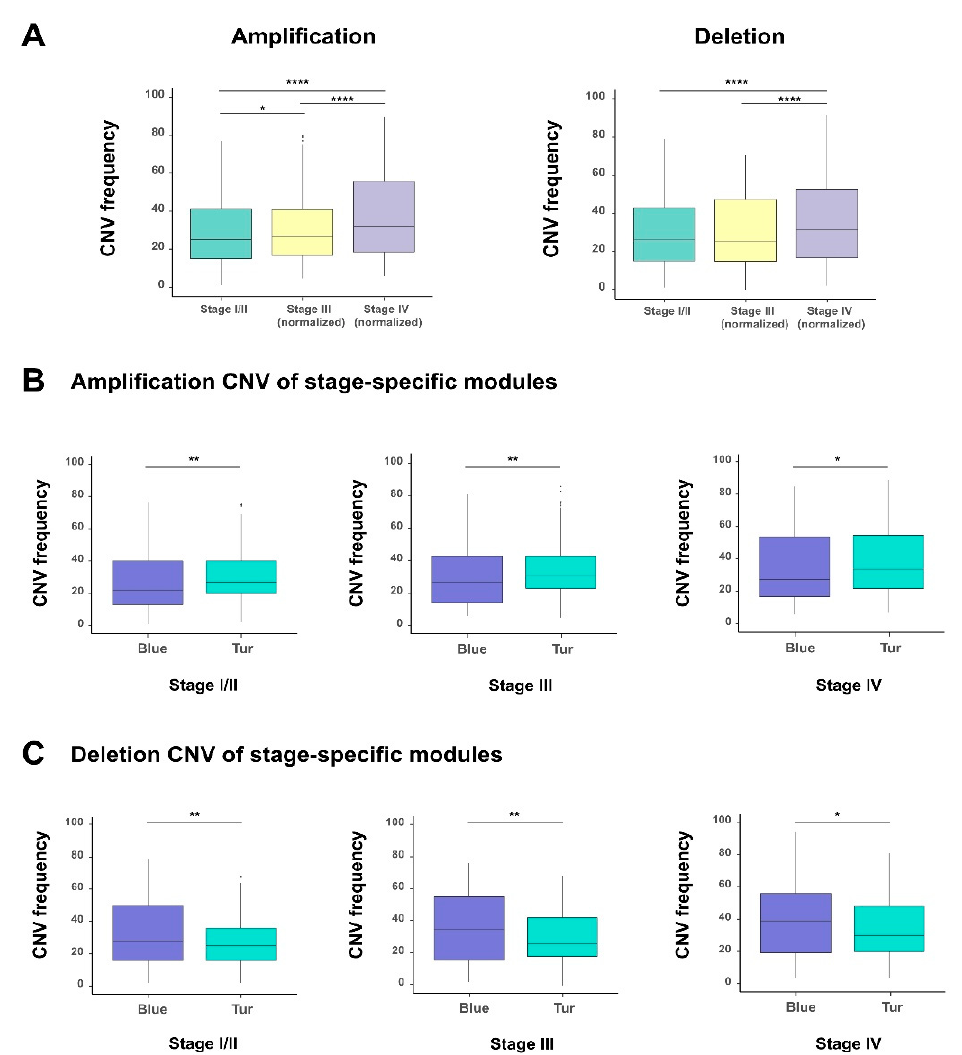
Figure 5. The analysis of copy number variations (CNVs) in di ff erent stages of bladder cancer. ( A ) The comparison of CNVs, including amplification and deletion between di ff erent stages of bladder cancer. The comparison of amplification ( B ) and deletion ( C ) of CNVs between blue and turquoise modules (corresponding to those two groups identified in Figure 4, which were most positively and negatively correlated with the tumor stage feature, respectively) in all and stage-specific samples. * p -value < 0.05; ** p -value < 0.01; *** p -value < 0.001; two-sided Wilcoxon rank–sum test.